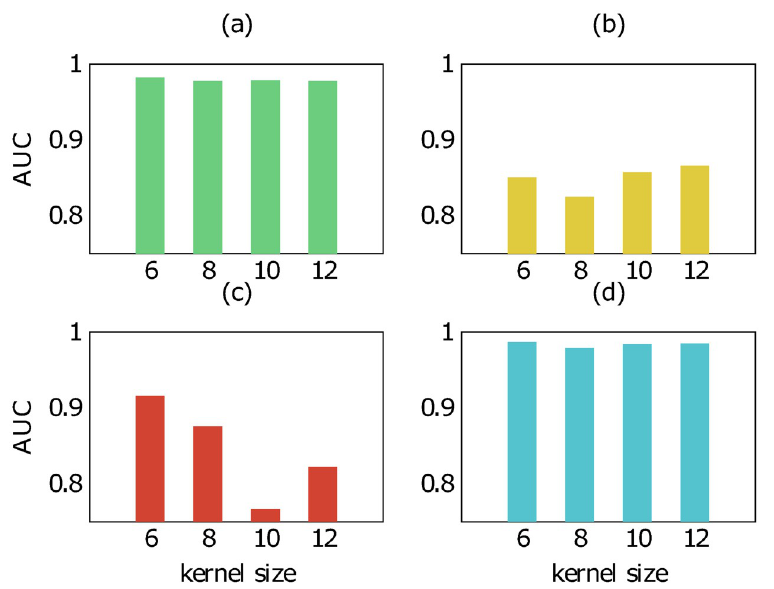
Fig 7. AUC score of our method trained with different kernel size on bindingdb data in four scenarios: (a) new compound-known protein, (b) known compound-new protein, (c) new compound-new protein, (d) known compound-known